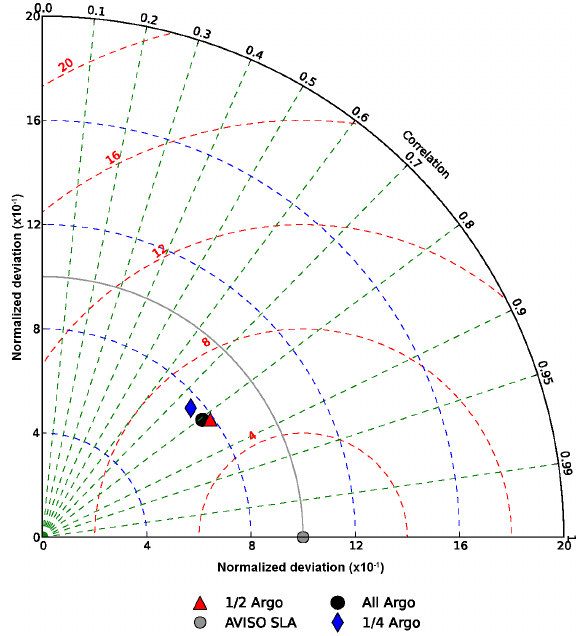
Figure 10. Taylor diagram of the steric contributions to the sea level derived from different sub-sampling of the Argo floats (DHAs ref- erenced to 900dbar) with the mass contribution (GRACE GRGS) compared with the AVISO SSALTO/DUACS merged altimeter SLAs. For each sub-sampling of the in situ data set, the correspond- ing collocated altimeter measurements are